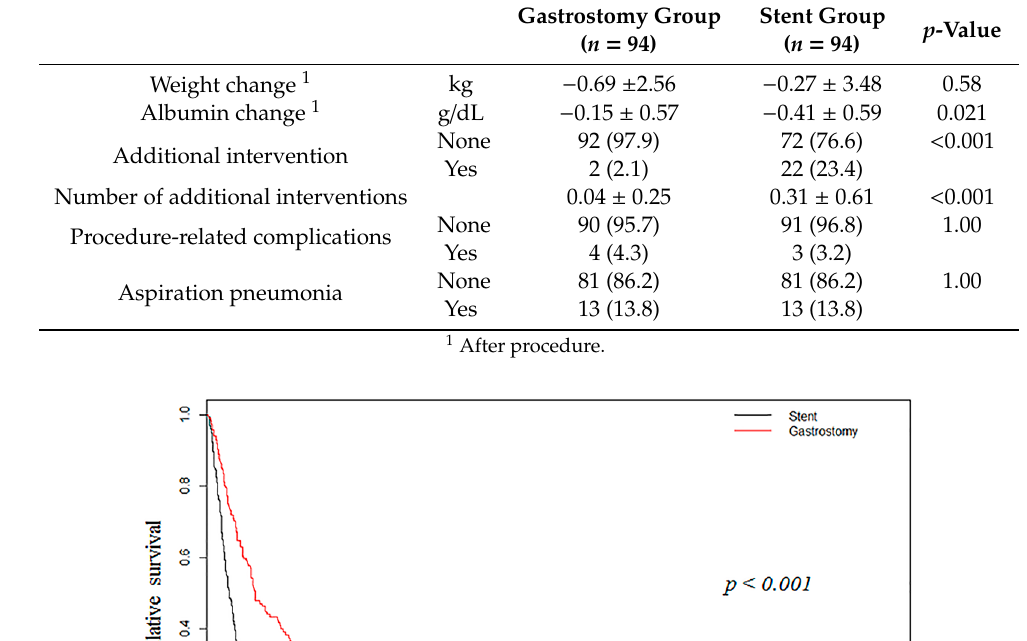
Table 3. Comparison of primary outcomes between patients with malignant esophageal obstruction undergoing gastrostomy and stent insertion, in the propensity score matched cohort (94 matched pairs).